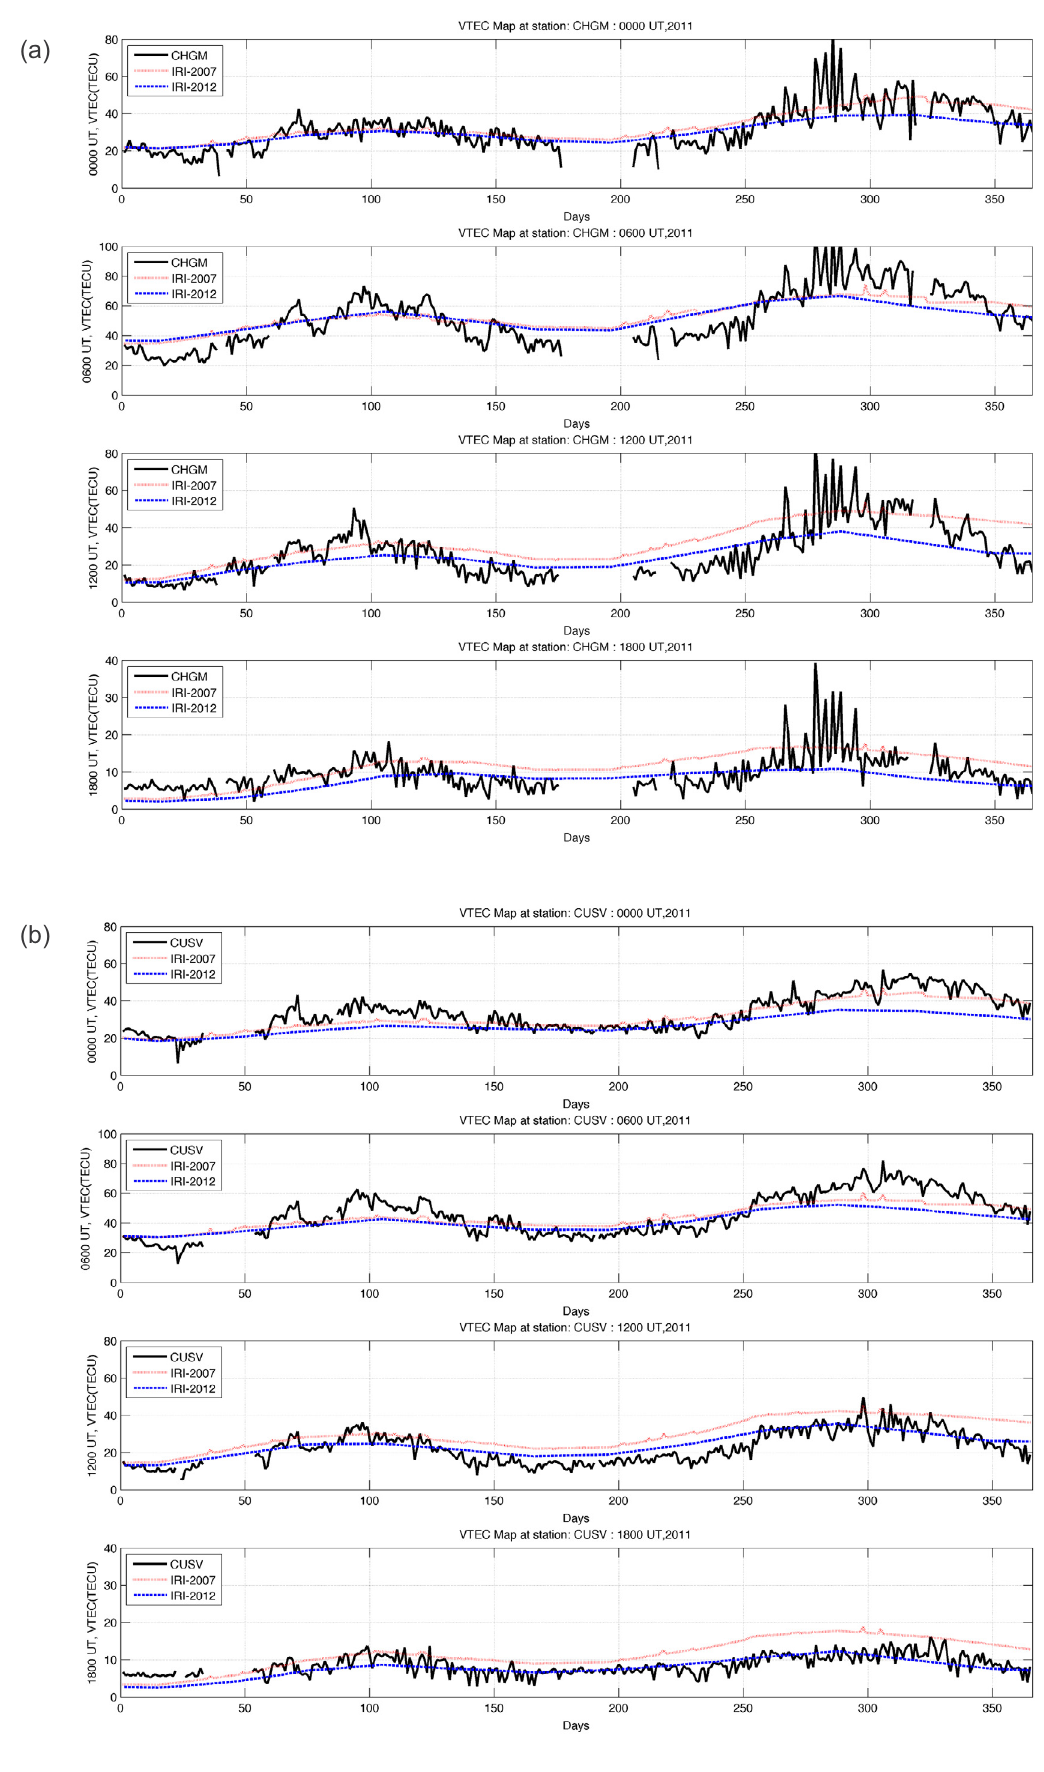
Figure 2. Mean variation of the GPS TEC, TEC from the IRI-2007 model and TEC from the IRI-2012 model, for the year 2011at CHGM and CUSV respectively sunrise, midday, post sunset and